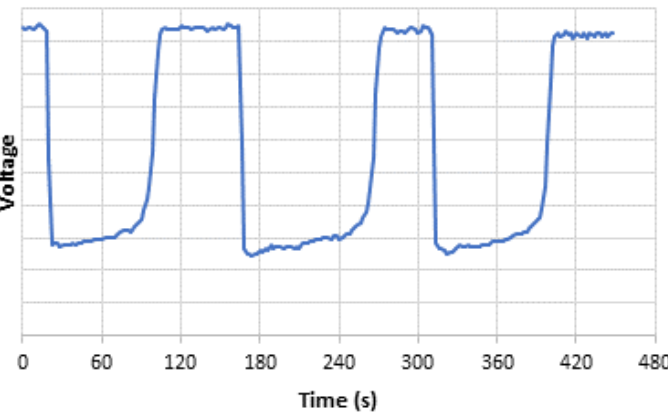
ff ect of acetone (three injections of 157 ppm acetone). Figure 9. Quenching effect of acetone (three injections of 157 ppm acetone). Figure 9. Quenching e